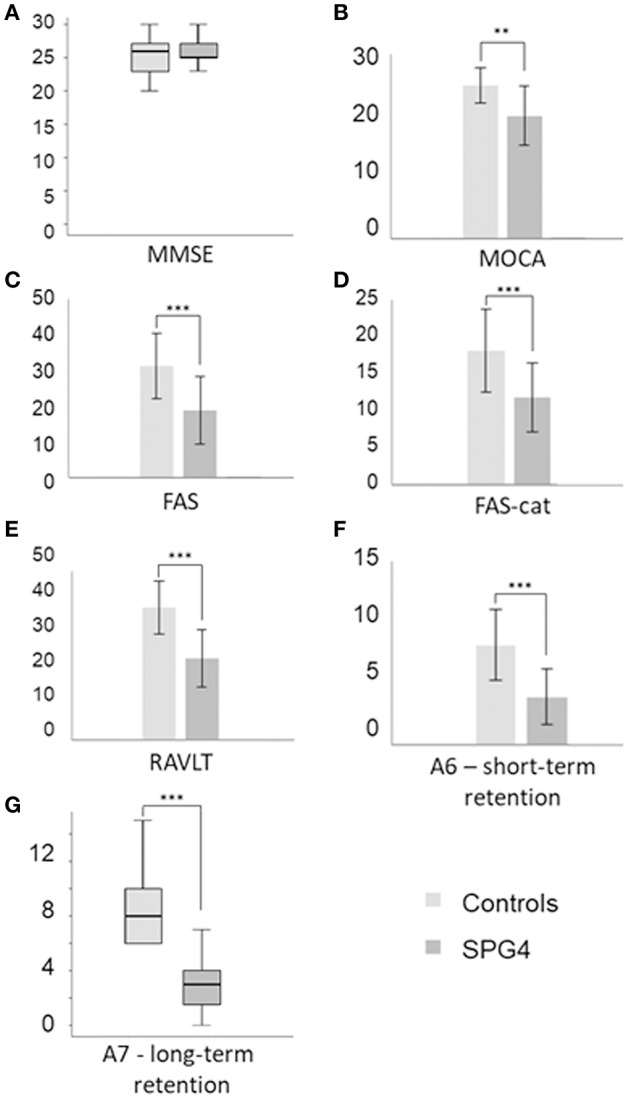
Comparison between control and SPG4 subjects performances in cognitive tests. Bars represent mean values and standard deviation. Box-plots represent median values and interquartile ranges. **P < 0.01 e ***P ≤ 0.001. FAS, verbal fluency with phonological restriction; FAS-cat, verbal categorical fluency (animals); MMSE, Mini Mental State Examination; MoCA, Montreal Cognitive Assessment; RVALT, A6 and A7, Rey's Verbal Auditory Learning Test. (A) MEEM, (B) MOCA, (C) FAS, (D) FAS-cat, (E) RVALT, (F) A6 - short-term retention, (G) A7 - long-term retention.